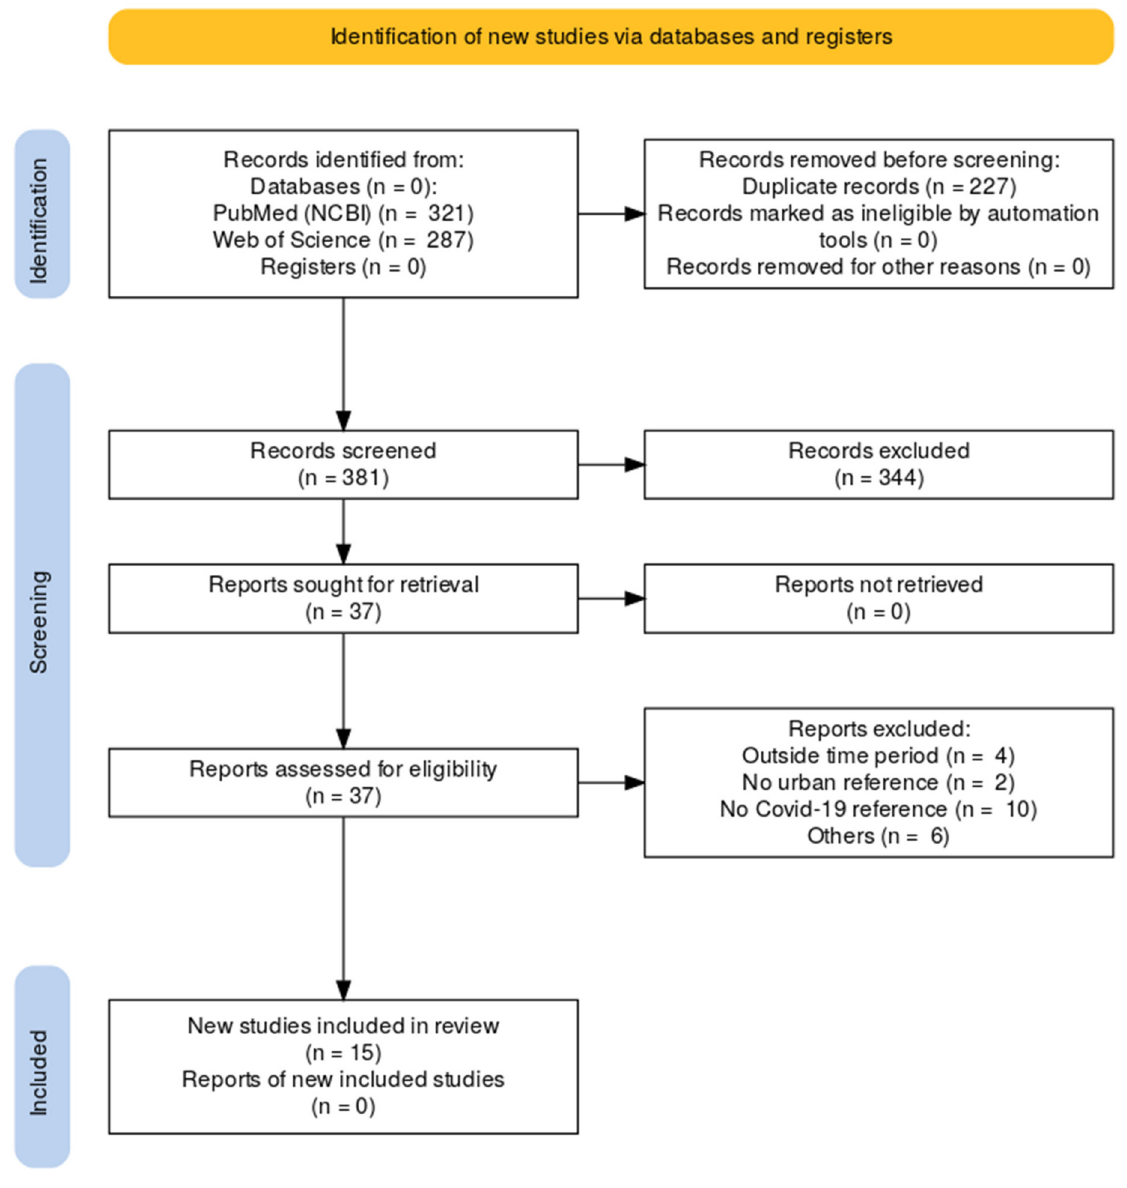
Figure 1. PRISMA Flow chart for the review of papers. Table 1. Inclusion and exclusion criteria for literature